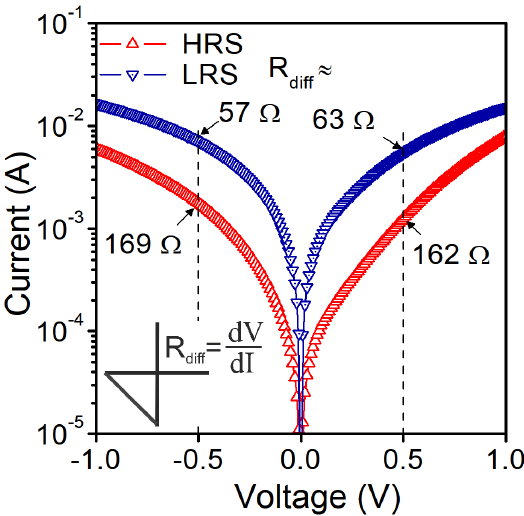
Figure 12. R diff values extracted from the measurements of S1 structure at different resistance states and considered gate bias voltages.